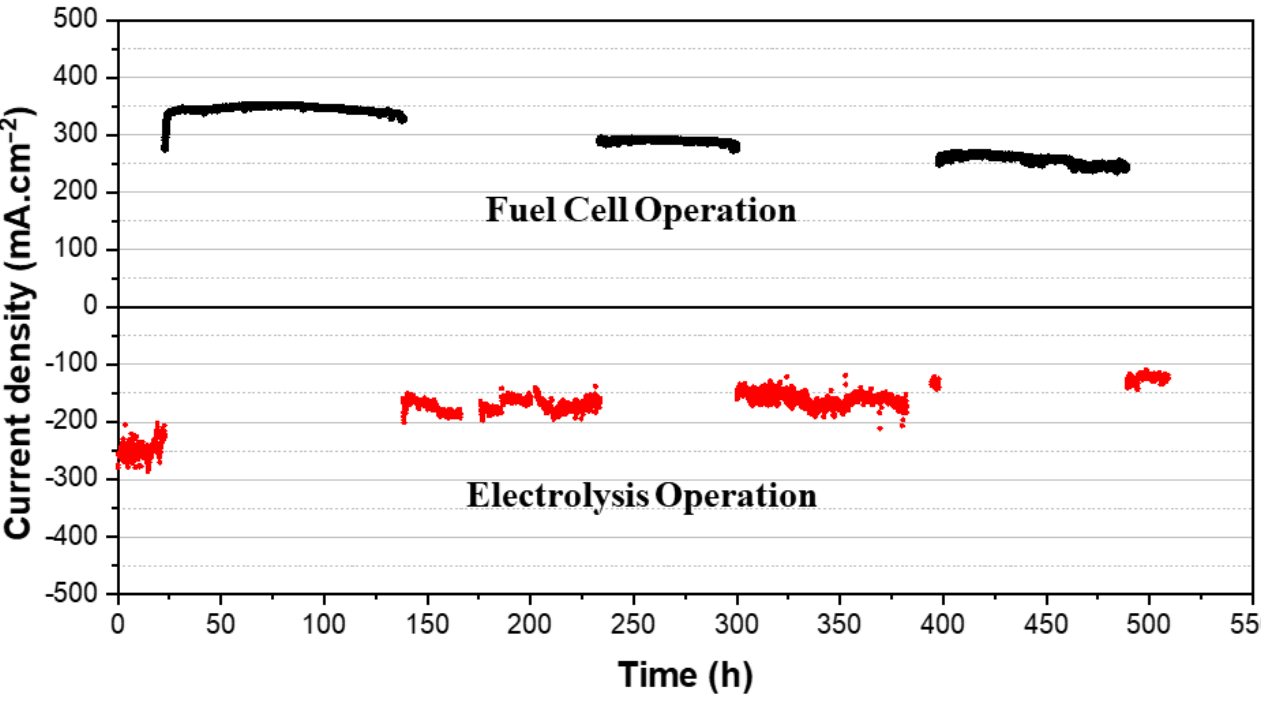
Figure 8. Stability test at 700 °C under reversible mode.